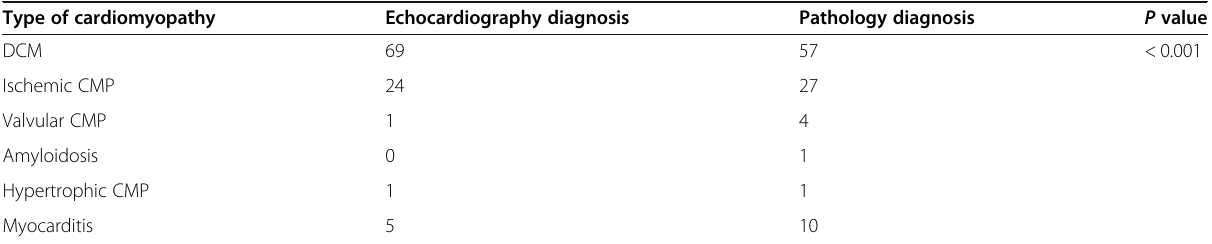
Table 3 Comparison the frequency of different types of cardiomyopathy based on two different diagnostic methods Type of